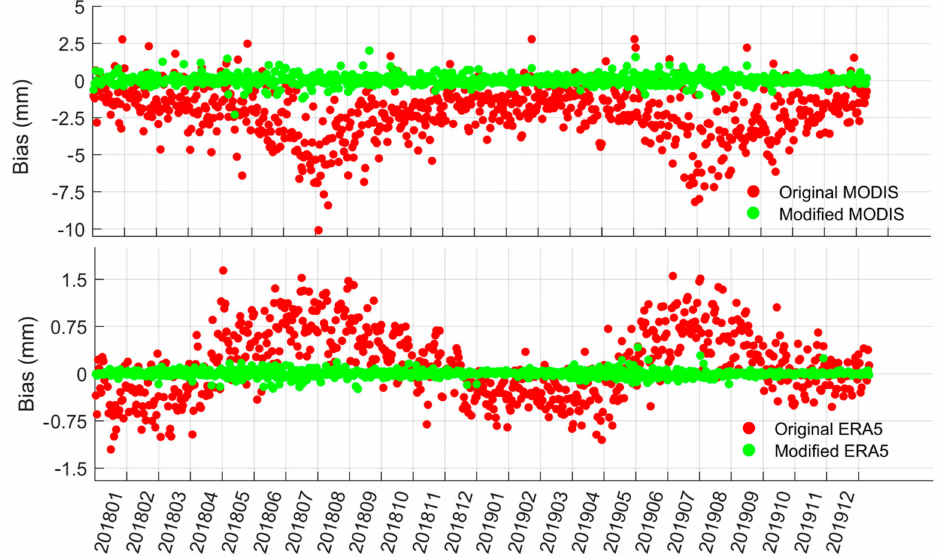
Figure 6. Daily PWV biases of the original MODIS (ERA5) PWV and the modified MODIS (ERA5) PWV.